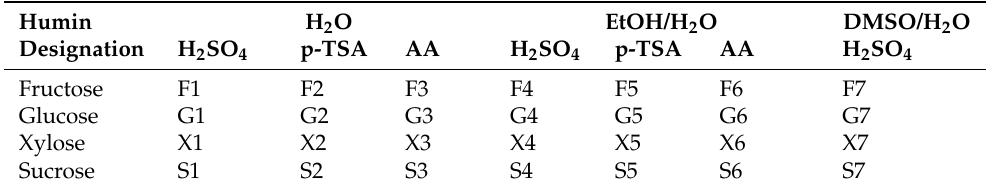
Table 1. Matrix of the humin formation experiments.